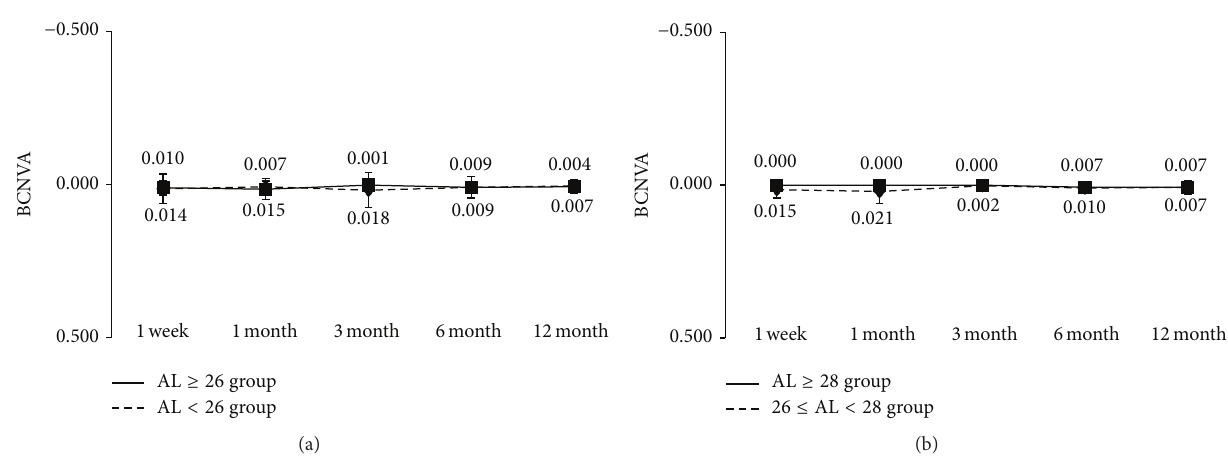
Figure 4: Best corrected near visual acuity during 12-month follow-up after implantation of multifocal intraocular lens. (a) Eyes were divided into axial length of 26 mm or longer (AL ≥ 26 group) and less than 26 mm (AL < 26 group). (b) Eyes in AL ≥ 26 group were further divided into 26 ≤ AL < 28 group and AL ≥ 28 group. ∗ NS Mann-Whitney 𝑈 test.